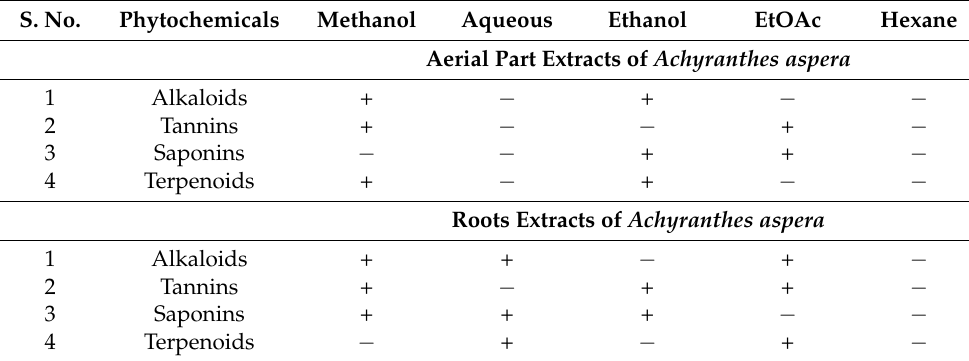
Table 2. Phytochemical screening of alkaloids, tannins, saponins, and terpenoids present in the various plant